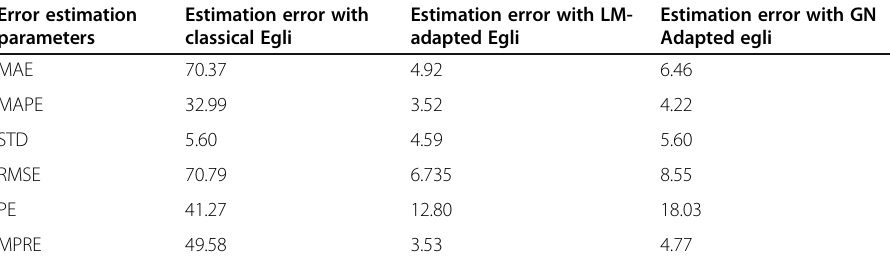
Table 6 Computed first order estimates statistics for Cell_4 Error estimation